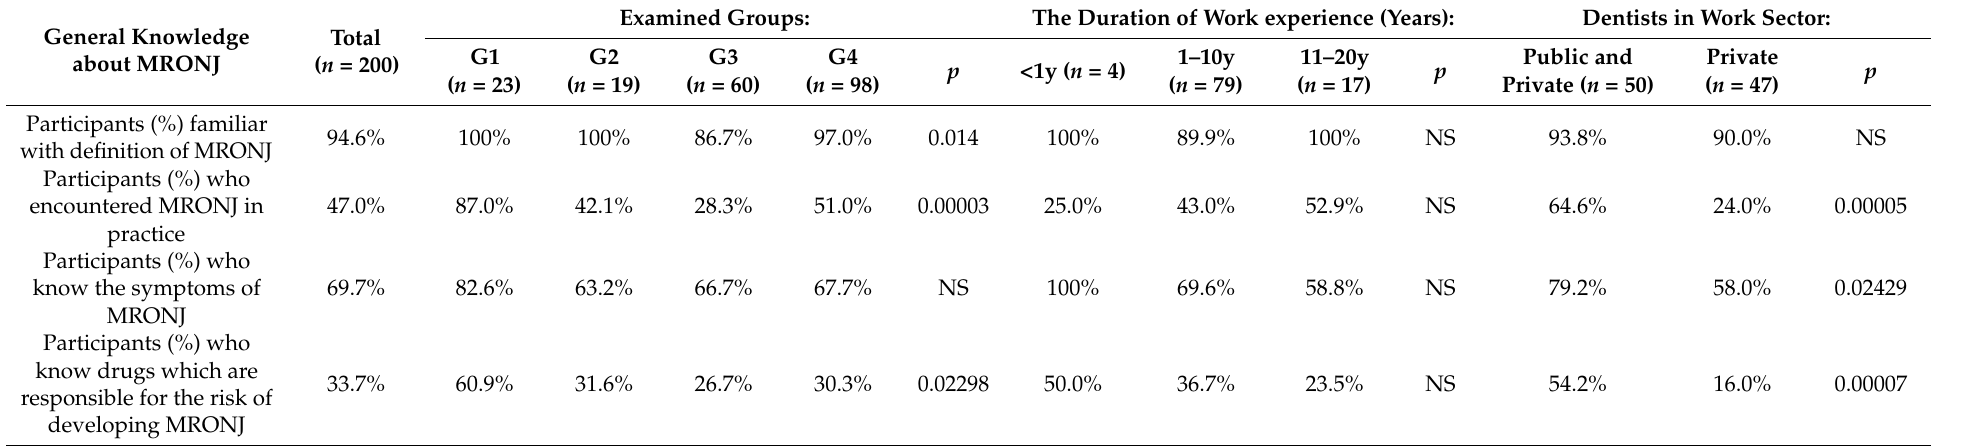
Table 1. General knowledge about MRONJ.